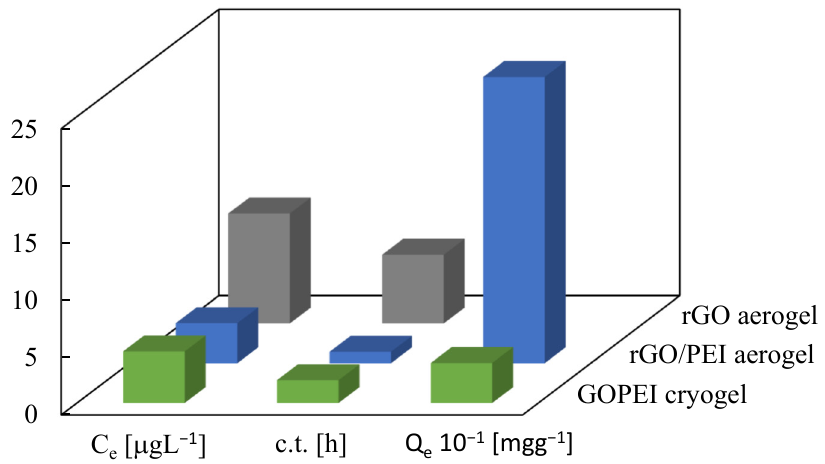
Figure 8. A diagram comparing the sorption data for a GOPEI cryogel (from [20]) and the rGO/PEI and rGO aerogels synthetized in this work.